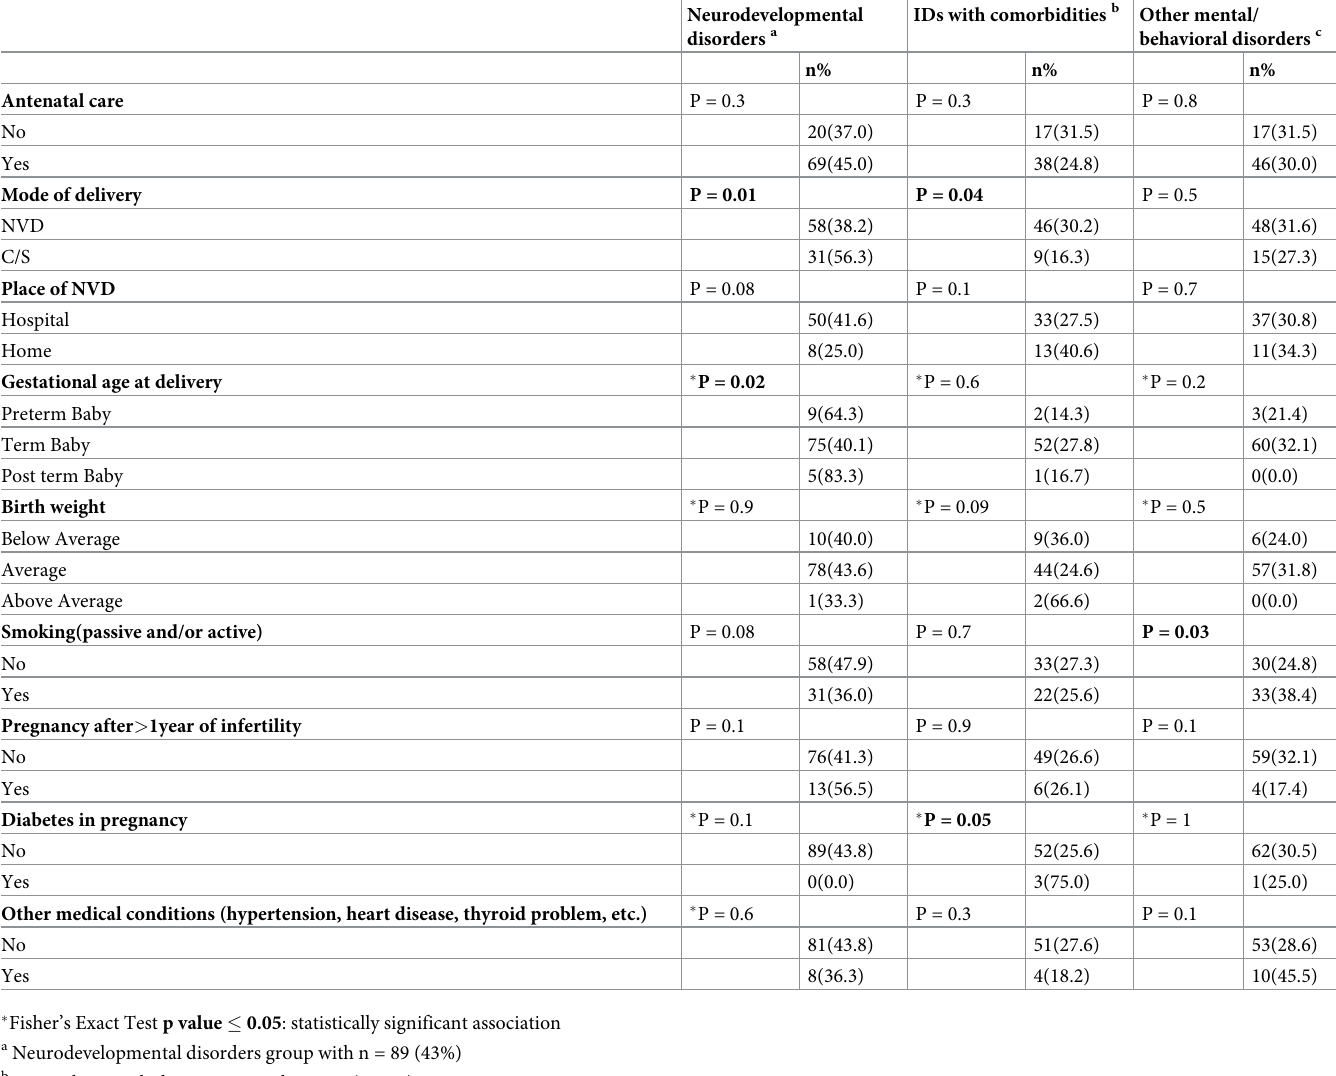
Table 8. Chi-square association test of pregnancy and birth characteristics and